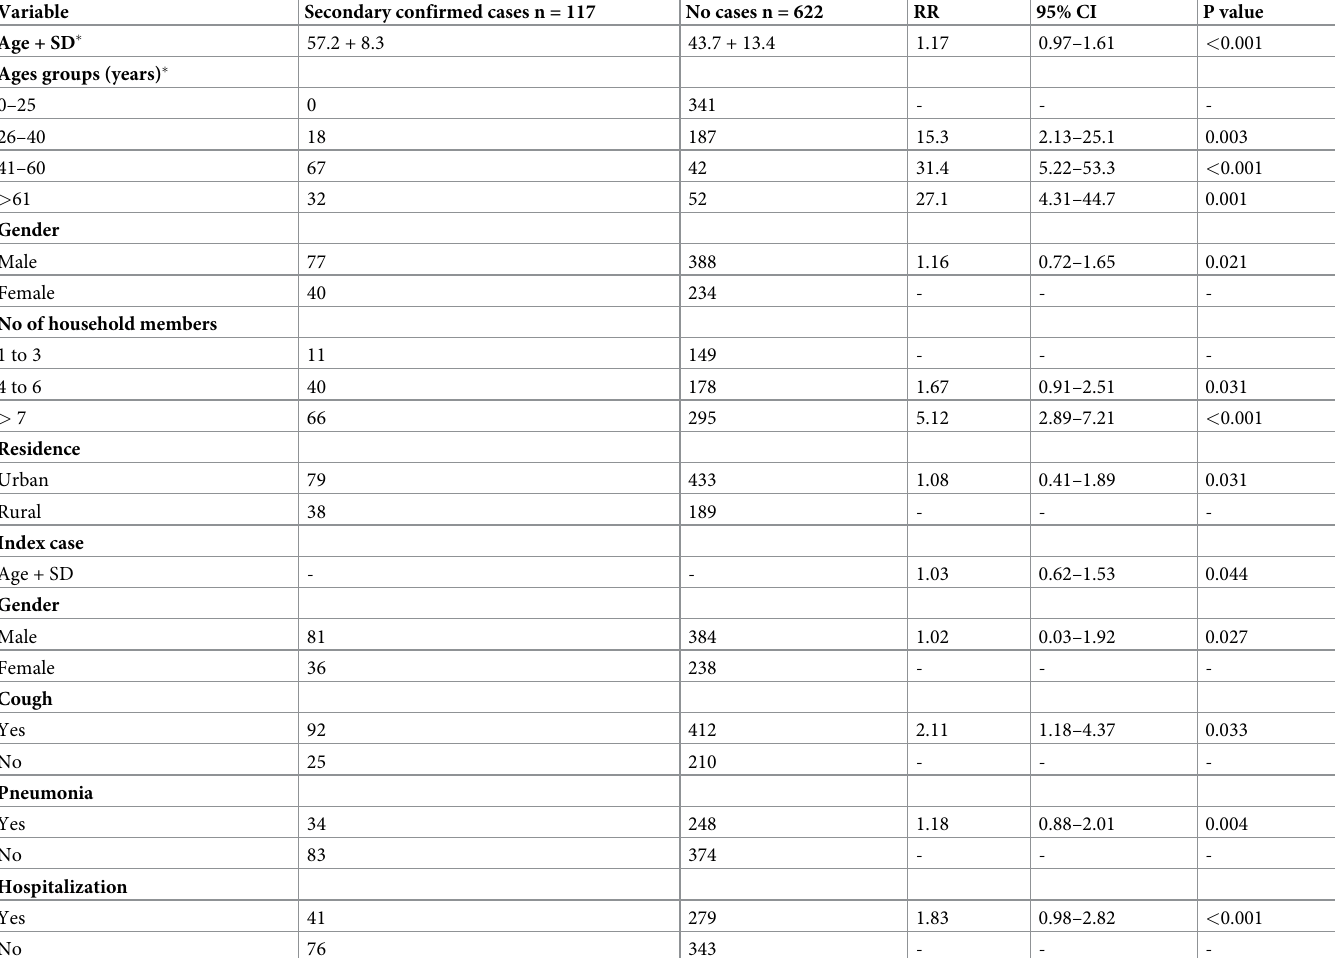
Table 2. Confirmed secondary COVID-19 cases risk factors analysis through Univariate Poisson regression in the Province of Khyber Pakhtunkhwa and Punjab, Pakistan, Feb 26th-April 8th, 2020.